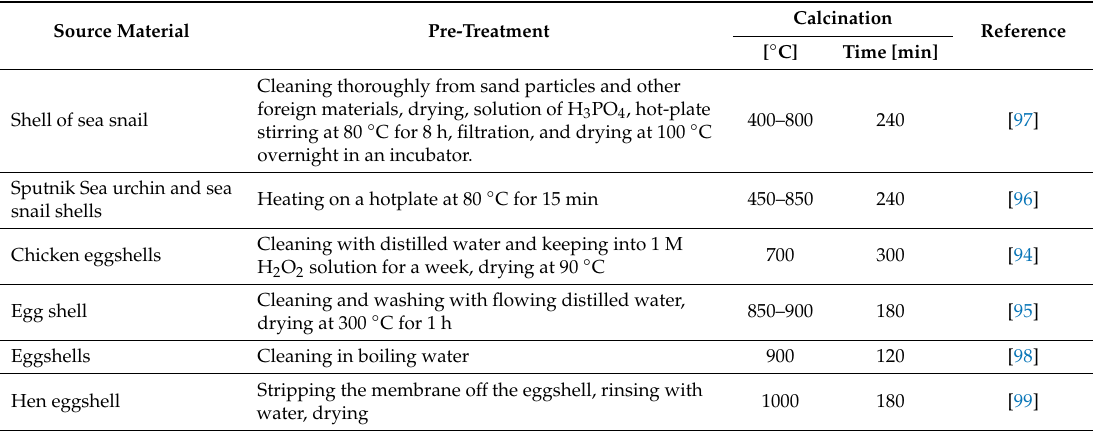
Table 5. Preparation of HA powders derived from biogenic sources, presented in the order of the calcination